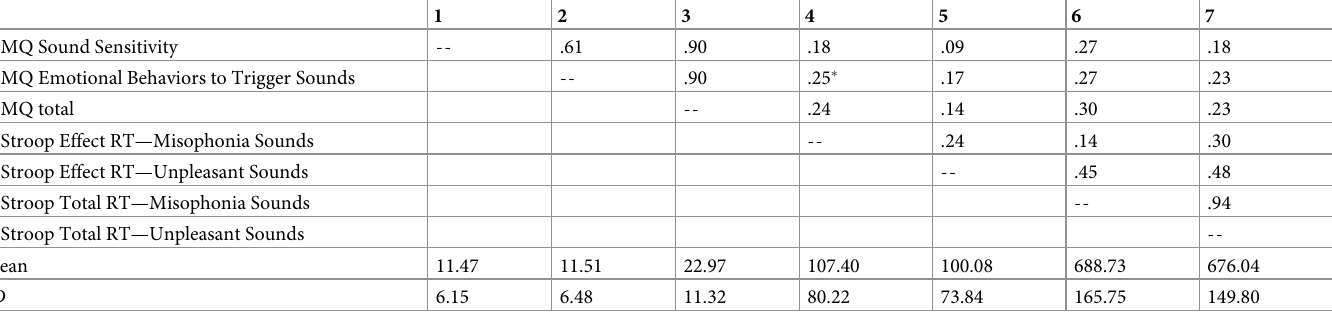
Table 1. Zero-order correlations among MQ sound sensitivity, MQ emotional behaviors towards trigger sounds, MQ total score, and performance on the Stroop task.